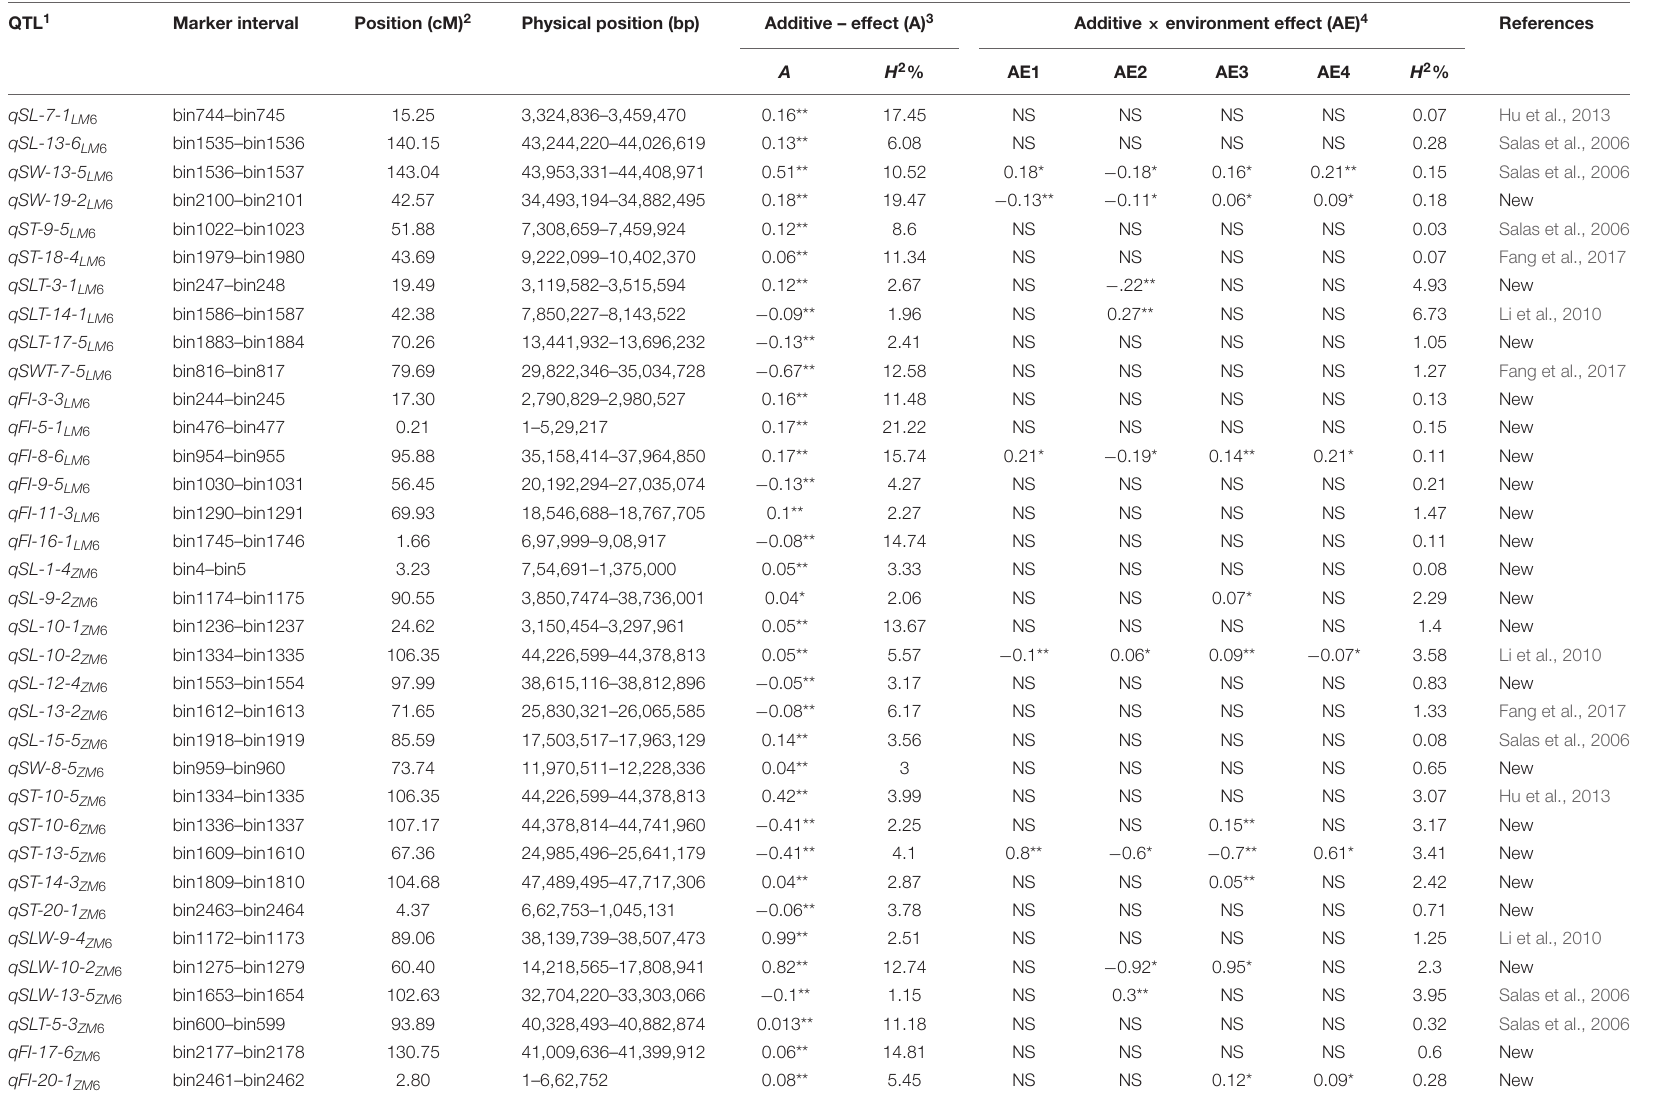
TABLE 1 | 1 QTL naming followed nomenclature q for quantitative trait locus, trait name seed size [seed length (SL), thickness (ST), and width (SW)] and seed shape [length to-thickness (SLT), length-to-width (SLW), width-to-thickness (SWT) ratios, and flatness index (FI)] followed by chromosome number, number of QTLs detected on each chromosome for each trait and subscripted by name of recombinant inbred line population (LM6 and ZM6). 2 Genetic position of QTL (cM). 3 Additive effect (A) and phenotypic variation explained by QTL(PVE). 4 Additive by environment effect in FY2012 (AE1); JP2012 (AE2); JP2014 (AE3); and JP2017